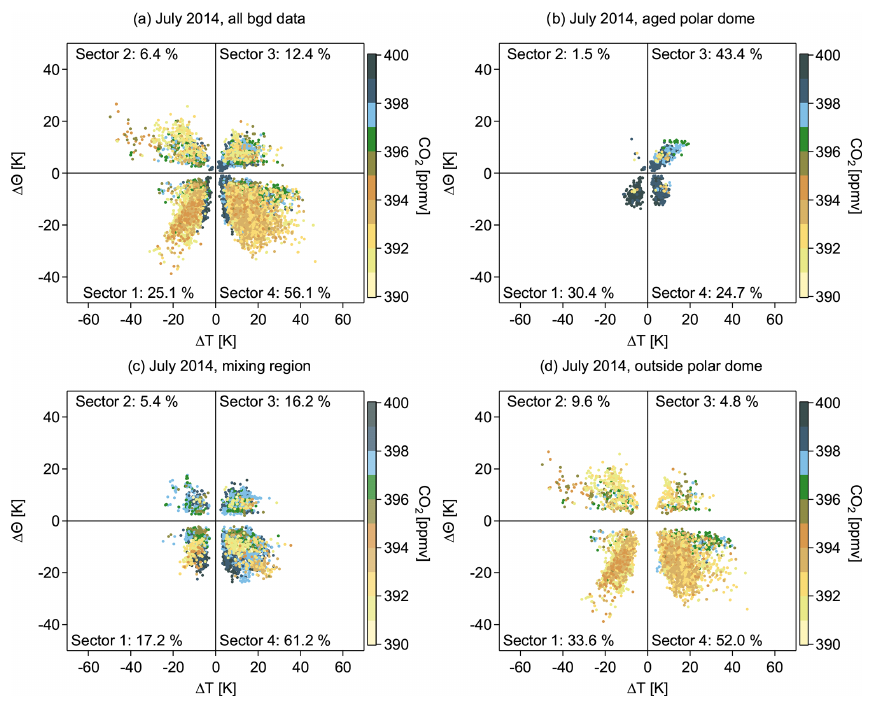
Figure 10. Phase-space diagram illustrating the maximum absolute change in temperature ( (cid:49)T ) and potential temperature ( (cid:49)(cid:50) ) relative to the time of the measurement for July 2014. The color code denotes the CO 2 mixing ratio at the time of the measurement. Panel (a) shows all background data, panel (b) shows only those data corresponding to the aged polar dome, and panel (c) shows the data points within the mixing region, whereas panel (d) includes all data points outside the polar dome. To separate the different regions the tracer-derived polar dome boundaries are used (see Table